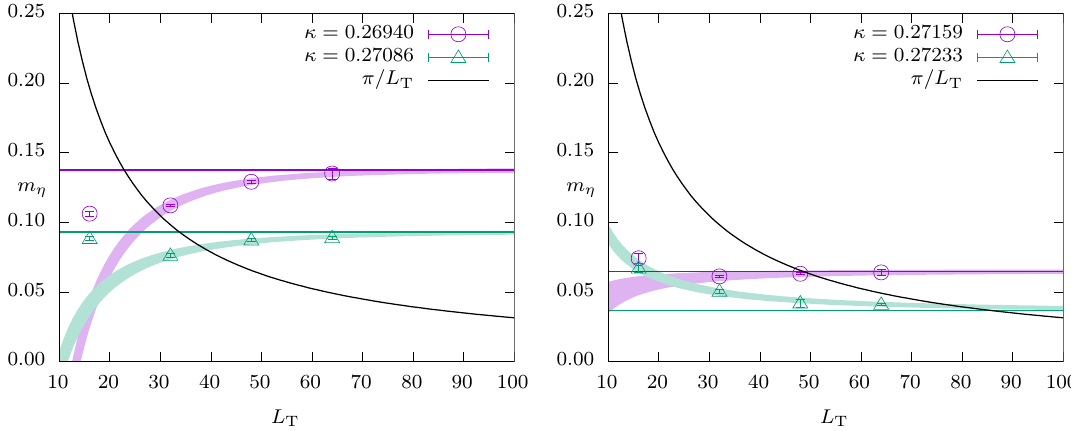
Figure 8. In(cid:12)nite volume extrapolation for the mass of the (cid:17) -meson at (cid:12) = 14 and di(cid:11)erent values of the hopping parameter (cid:20) compared to the smallest lattice momentum (cid:25)=L T . The horizontal lines indicate the in(cid:12)nite volume mass m